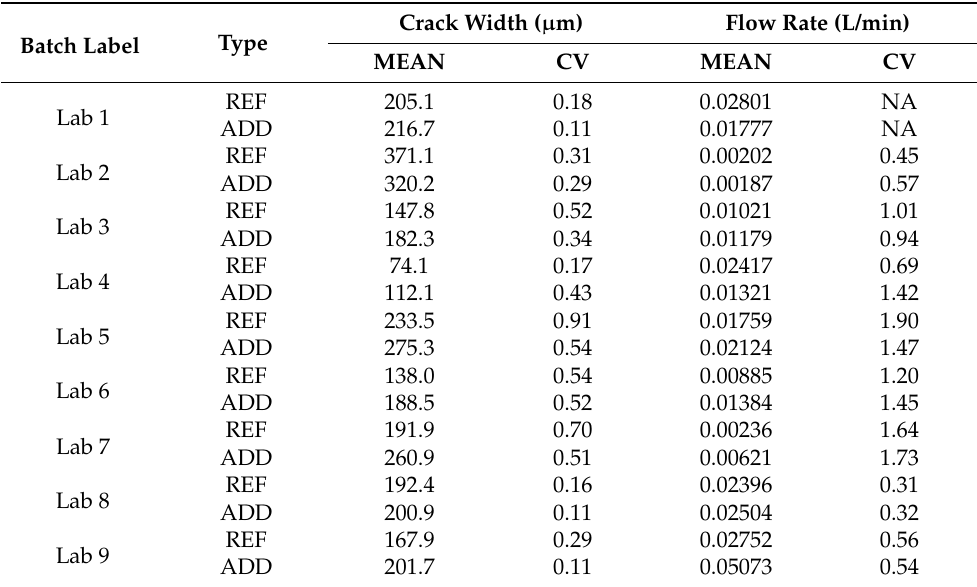
Figure 15. The sealing efficiency SE flow based on water flow tests measured in the different labs. * denotes a longer healing period adopted.